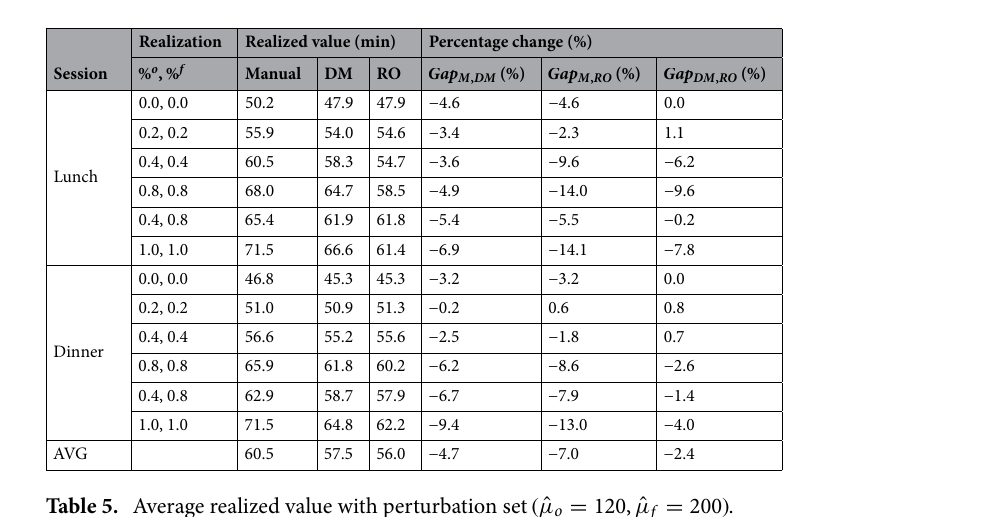
Table 5. Average realized value with perturbation set ( ˆ µ o = 120, ˆ µ f = 200 ) .